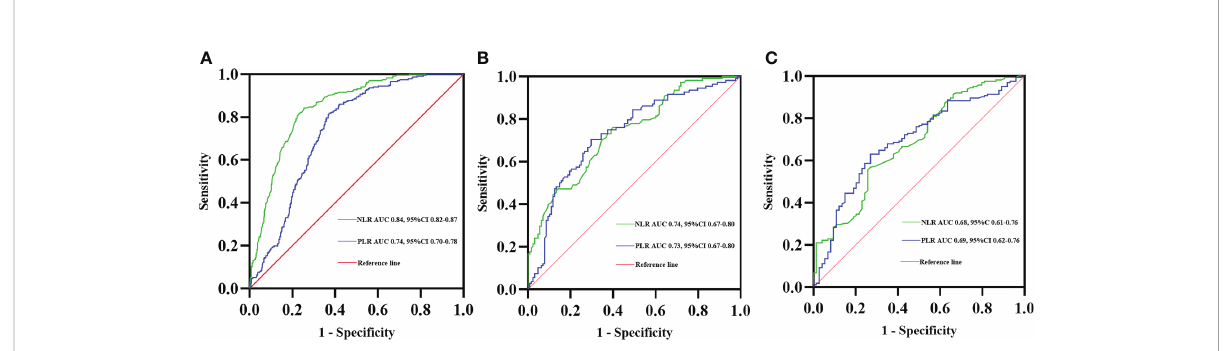
FIGURE 2 Receiver operating characteristic (ROC) curves of NLR and PLR predicting lung cancer diagnosis in COPD patients (A) . ROC curves of NLR and PLR predicting TNM stages IIIB – IV at fi rst diagnosis in the COPD with lung cancer patients (B) . ROC curves of NLR and PLR predicting ineligible surgery at fi rst diagnosis in the COPD with lung cancer patients (C)